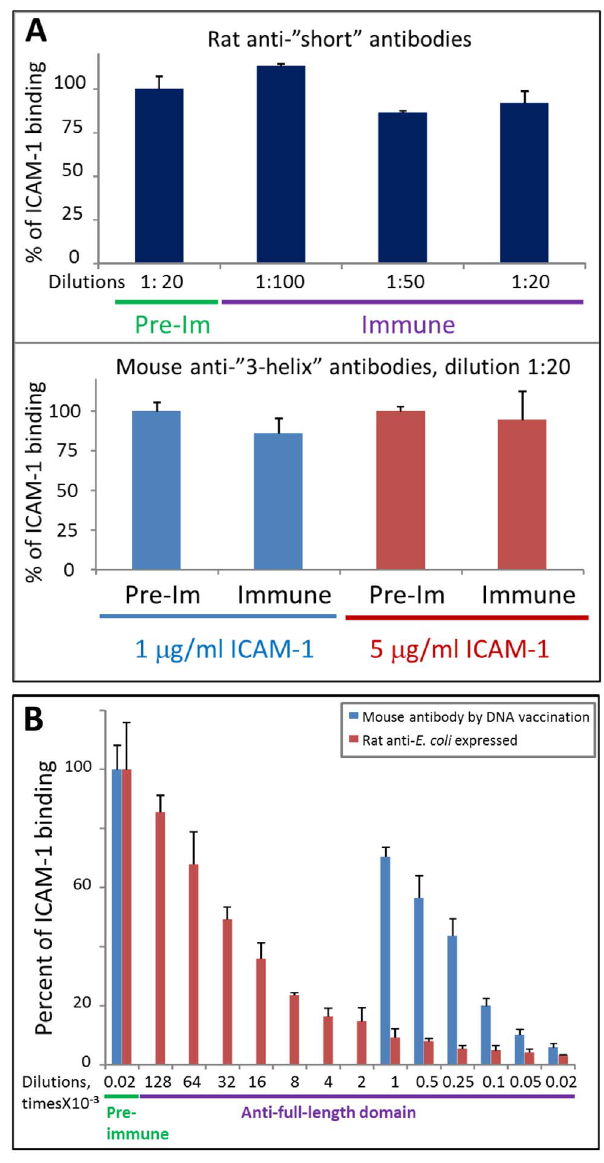
various DBL2 domain constructs. A . Antibodies against ‘‘short’’ (top) and ‘‘3-helix’’ (bottom) domains do not inhibit ICAM-1 binding to COS-expressed full-length domain. Pre-Im, pre-immune plasma as negative control. Error bars represent Standard Deviations. B . Antibod- ies against full-length domain can completely inhibit ICAM-1 binding to COS-expressed full-length domain. Mouse antibodies were titrated down to 1:1000